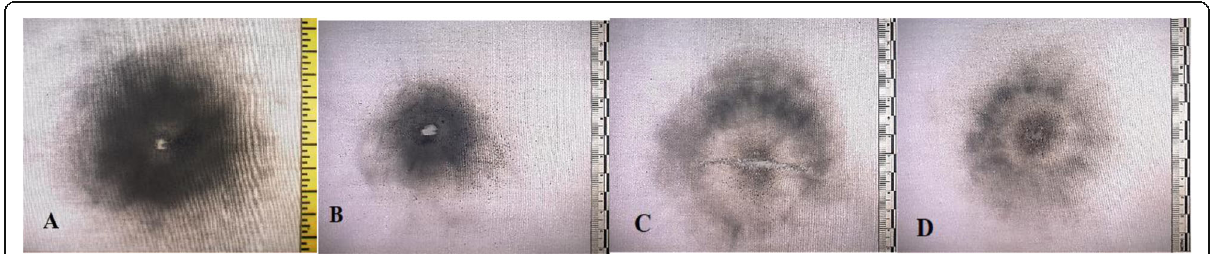
Fig. 2 Different pattern distribution of soots and GSR particles using firearms ( a _.38SME), ( b _.38SME). ( c _9SME) and ( d _9SME) at 3 cm of shooting distances